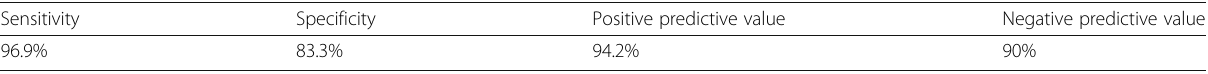
Table 1 Demonstrates the sensitivity, specificity, and positive and negative predictive values of 18F-FDG PET/CT in detecting recurrent colorectal